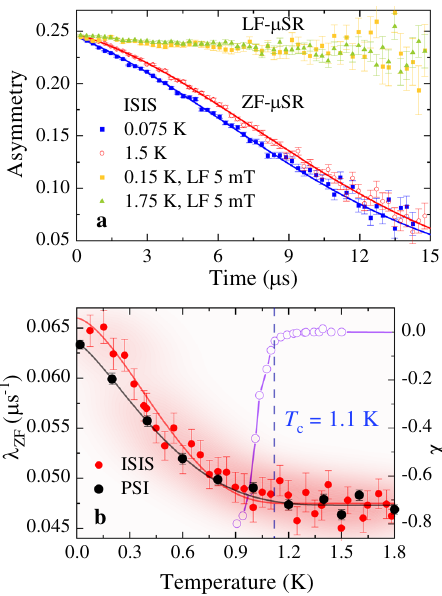
Fig. 1 Evidence of TRS-breaking superconductivity in LaPt 3 P by ZF- μ SR measurements. a ZF- μ SR time spectra collected at 75 mK and 1.5 K for sample-A of LaPt 3 P. The solid lines are the fi ts to the data using Eq. (1). b The temperature dependence of the extracted λ ZF (left axis) for sample-A (ISIS) and sample-B (PSI) showing a clear increase in the muon-spin relaxation rate below T c . The PSI data have been shifted by 0.004 μ s − 1 to match the baseline value of the ISIS data. Variation of the zero- fi eld-cooled magnetic susceptibility ( χ ) on the right axis for sample-B. The error bars in a and b show the standard deviations in the respective